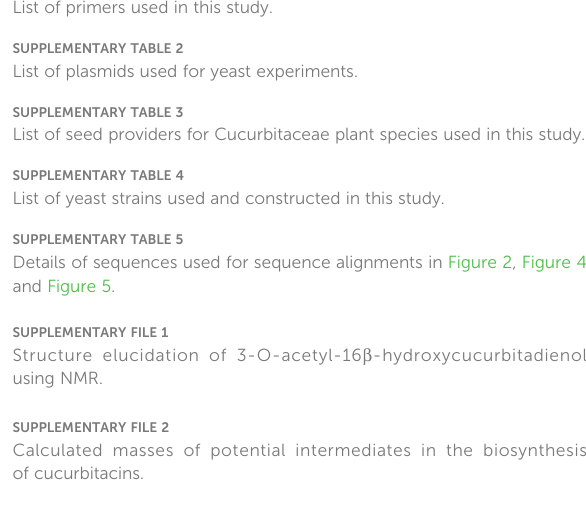
SUPPLEMENTARY TABLE 1 List of primers used in this study. SUPPLEMENTARY TABLE 2 List of plasmids used for yeast experiments. SUPPLEMENTARY TABLE 3 List of seed providers for Cucurbitaceae plant species used in this study. SUPPLEMENTARY TABLE 4 List of yeast strains used and constructed in this study. SUPPLEMENTARY TABLE 5 Details of sequences used for sequence alignments in Figure 2, Figure 4 and Figure